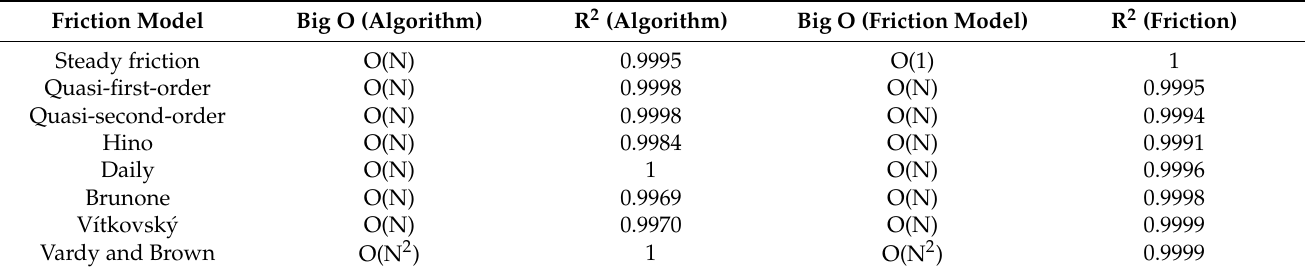
Table 6. Big O notation for different friction